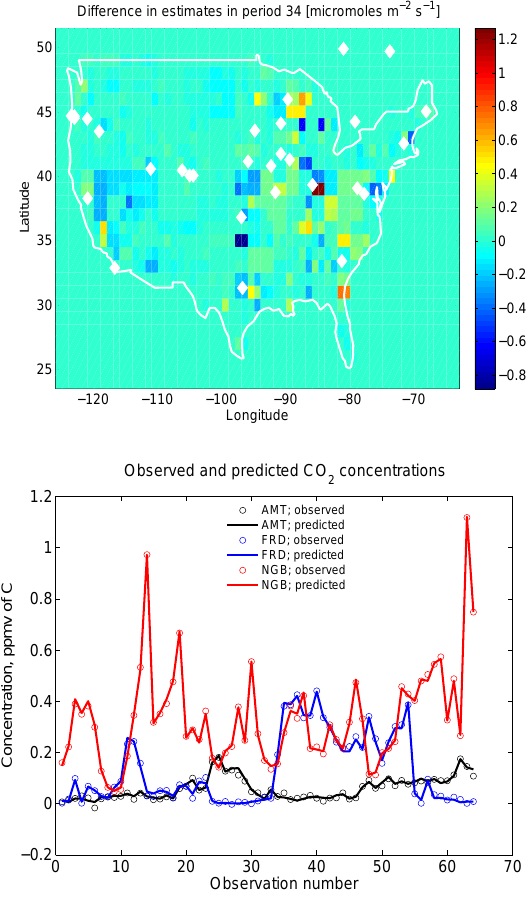
Figure 11. Top: comparison of emission estimates developed using f pr constructed from nightlight radiances and BUA maps. We plot Figure 11. Top: Comparison of emission estimates developed using f constructed from nightlight radi- pr the difference between the two estimates. We see that differences ances and BUA maps. We plot the difference between the two estimates. We see that differences are not are not localized in any one area. Bottom: prediction of ffCO 2 con- centrations at three measurement locations, using the true (Vulcan; localized in any one area. Bottom: Prediction of ffCO concentrations at 3 measurement locations, using 2 plotted with symbols) and reconstructed emissions (blue lines) over the true (Vulcan; plotted with symbols) and reconstructed emissions (blue lines) over an 8 day period an 8-day period (Period no. 31). Observations occur every 3h. We see that the concentrations are accurately reproduced by the esti- (Period no. 34). Observations occur every 3 h. We see that the concentrations are accurately reproduced mated by the estimated emissions.